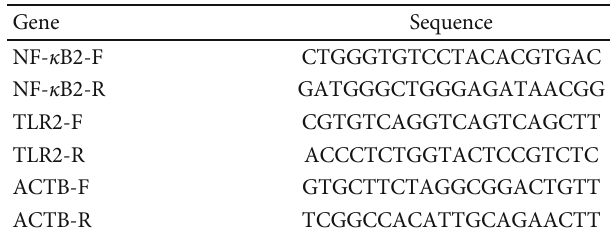
Table 3: Sequences of primers used in